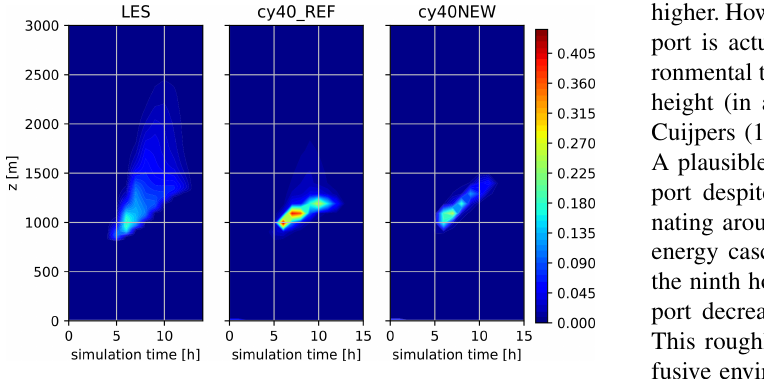
Figure 10. Contour plot of cloud fraction for the ARM case.